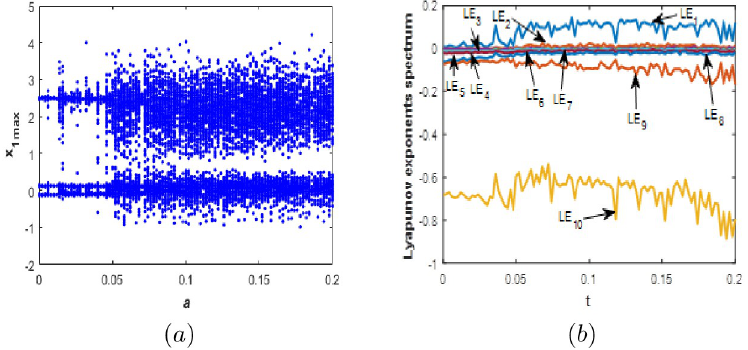
Fig 3. Bifurcation diagram (a) and Lyapunov exponents spectrum (b) of the new 10-D system (1) when: b = 0.1, c = 1.8, d = 0.01 and a 2